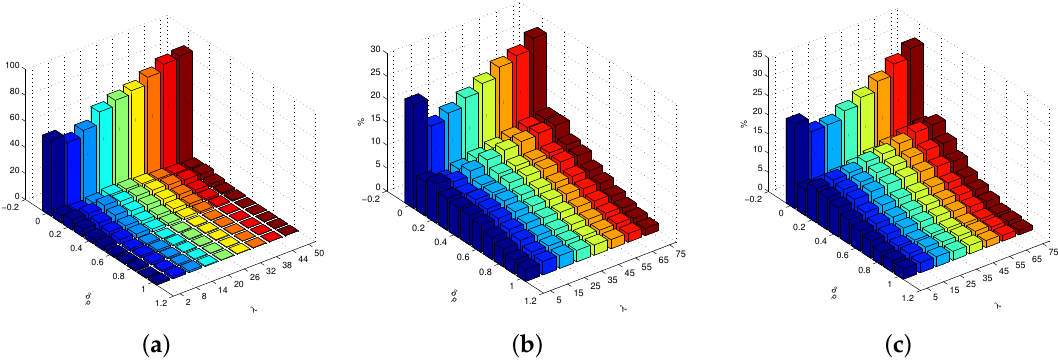
Figure 5. The results for the increased propagation delay of different SND-Lib topologies. ( a ) Abilene. ( b ) India. ( c ) Germany.